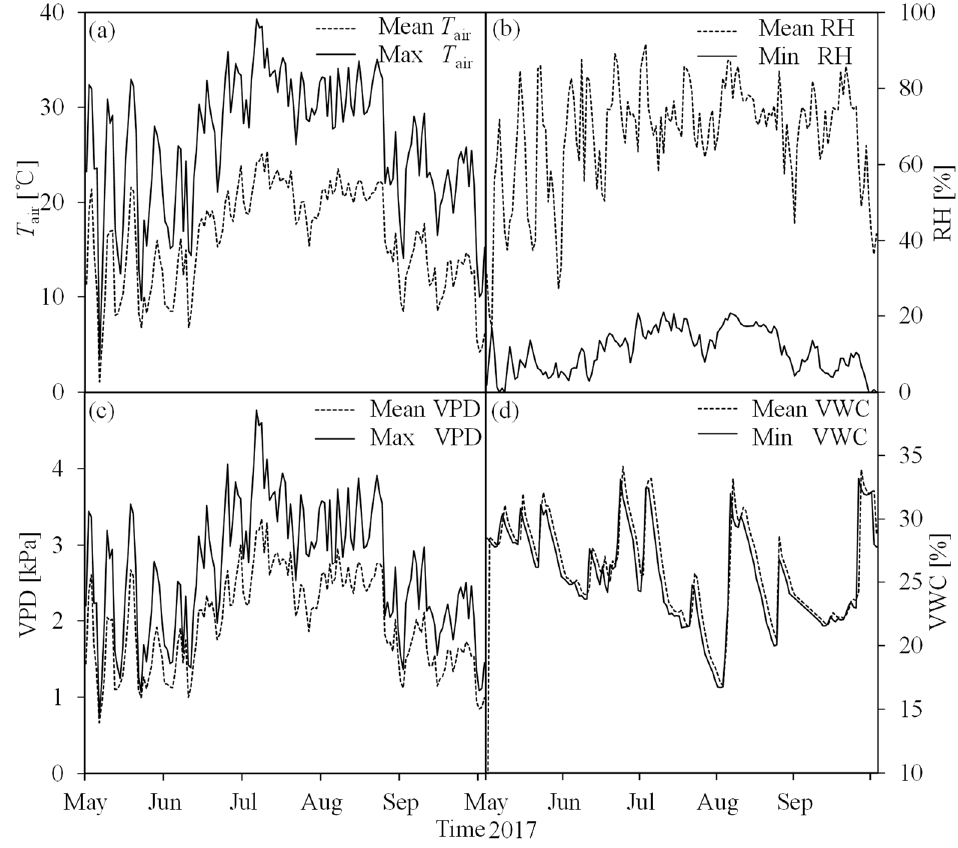
Figure 2. Seasonal course of the main environmental parameters during the period of this study (May–September 2017) : ( a ) daily mean air temperature (mean T air ) and maximum air temperature (max T air ); ( b ) daily mean relative humidity (mean RH) and minimum relative air humidity (min RH); ( c ) daily mean vapor pressure deficit (mean VPD) and maximum vapor pressure deficit (max VPD); ( d ) daily mean soil moisture (mean VWC) and minimum soil moisture (min VWC).